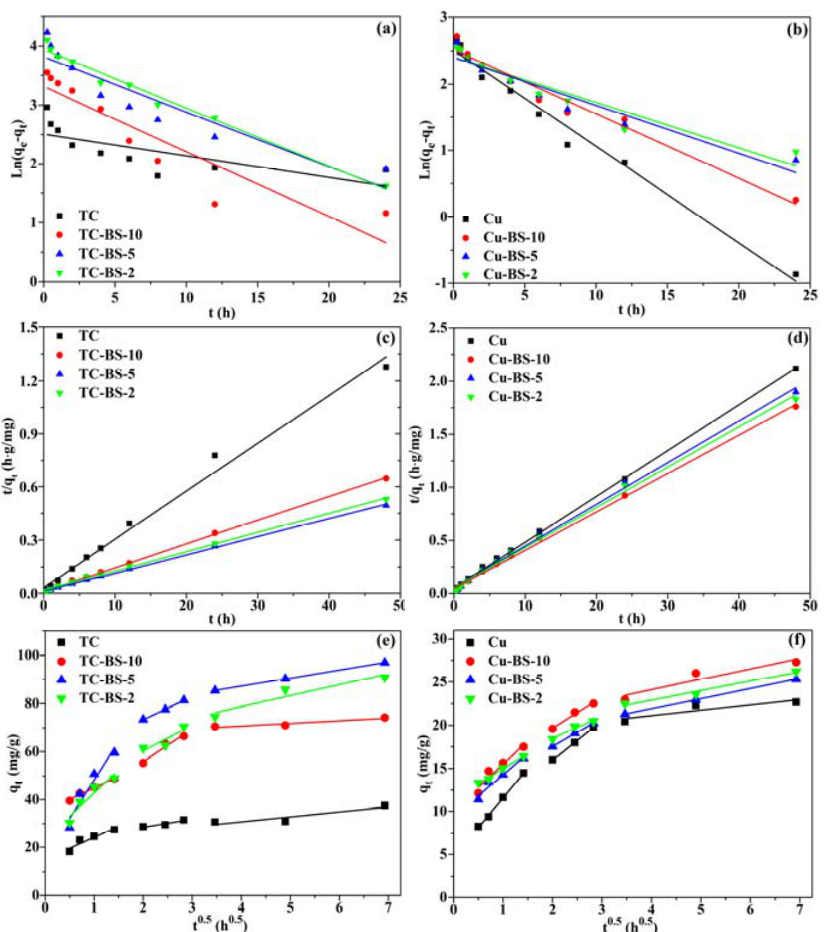
Figure 4. The fitted line of ( a , b ) pseudo-first-order kinetics model, ( c , d ) pseudo-second-order model; and ( e , f ) intra-particle diffusion model of A&C500 adsorbing of TC and Cu(II) under the single and binary systems.